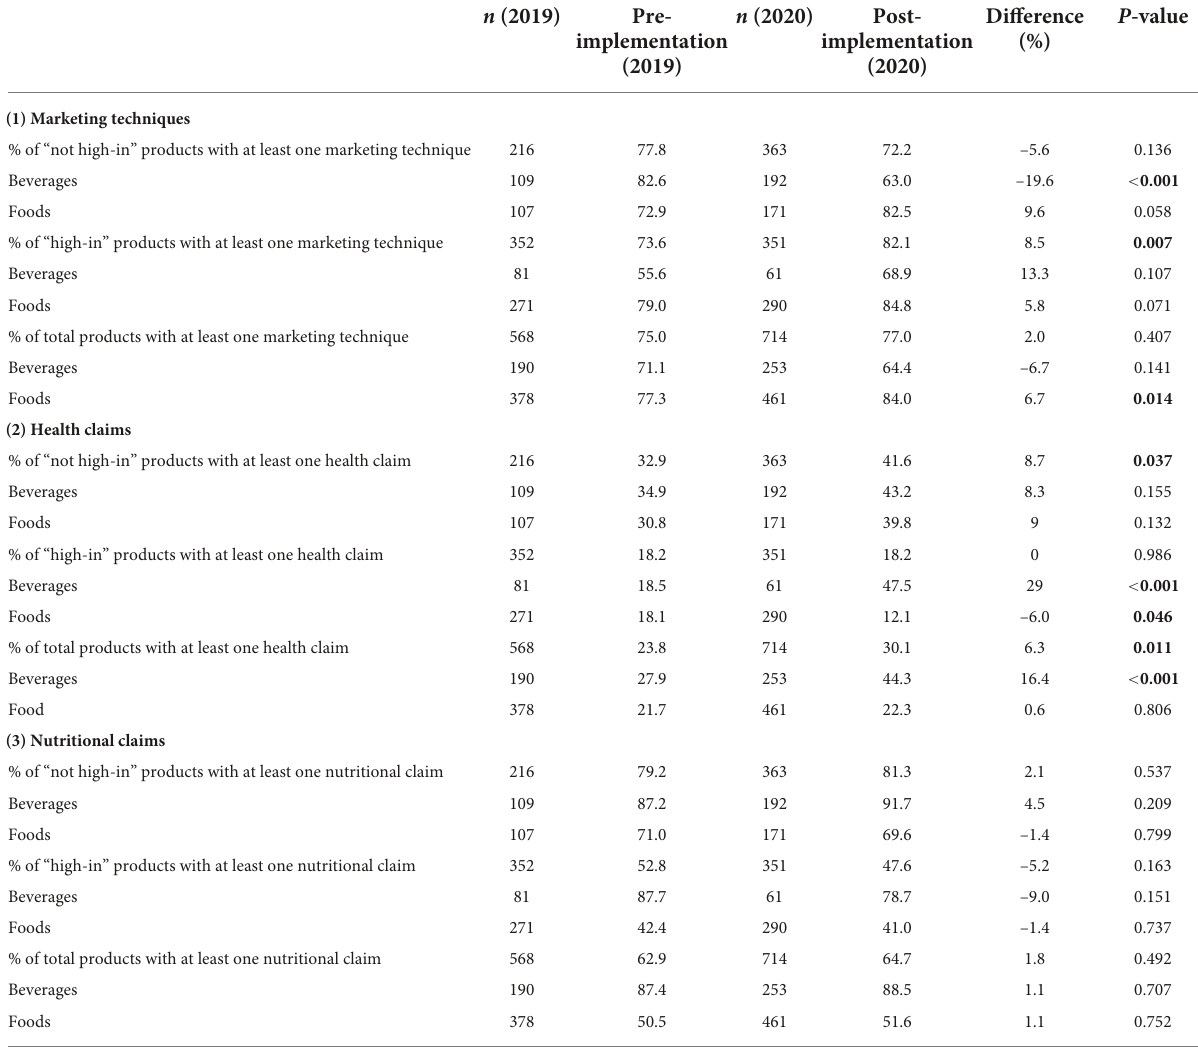
“High-in”productsareproductsexceedingatleastoneparameterinsugar,saturatedfatsorcontaining trans -fataccordingtothefirstphaseofthePeruvianlaw. Comparisonsofproportionsofmarketingtechniquesandclaimsinproductsfrompre- vs. post-implementationperiodweremadeusingChi-squaredandFisher’sexacttests.Boldvalues represent p <